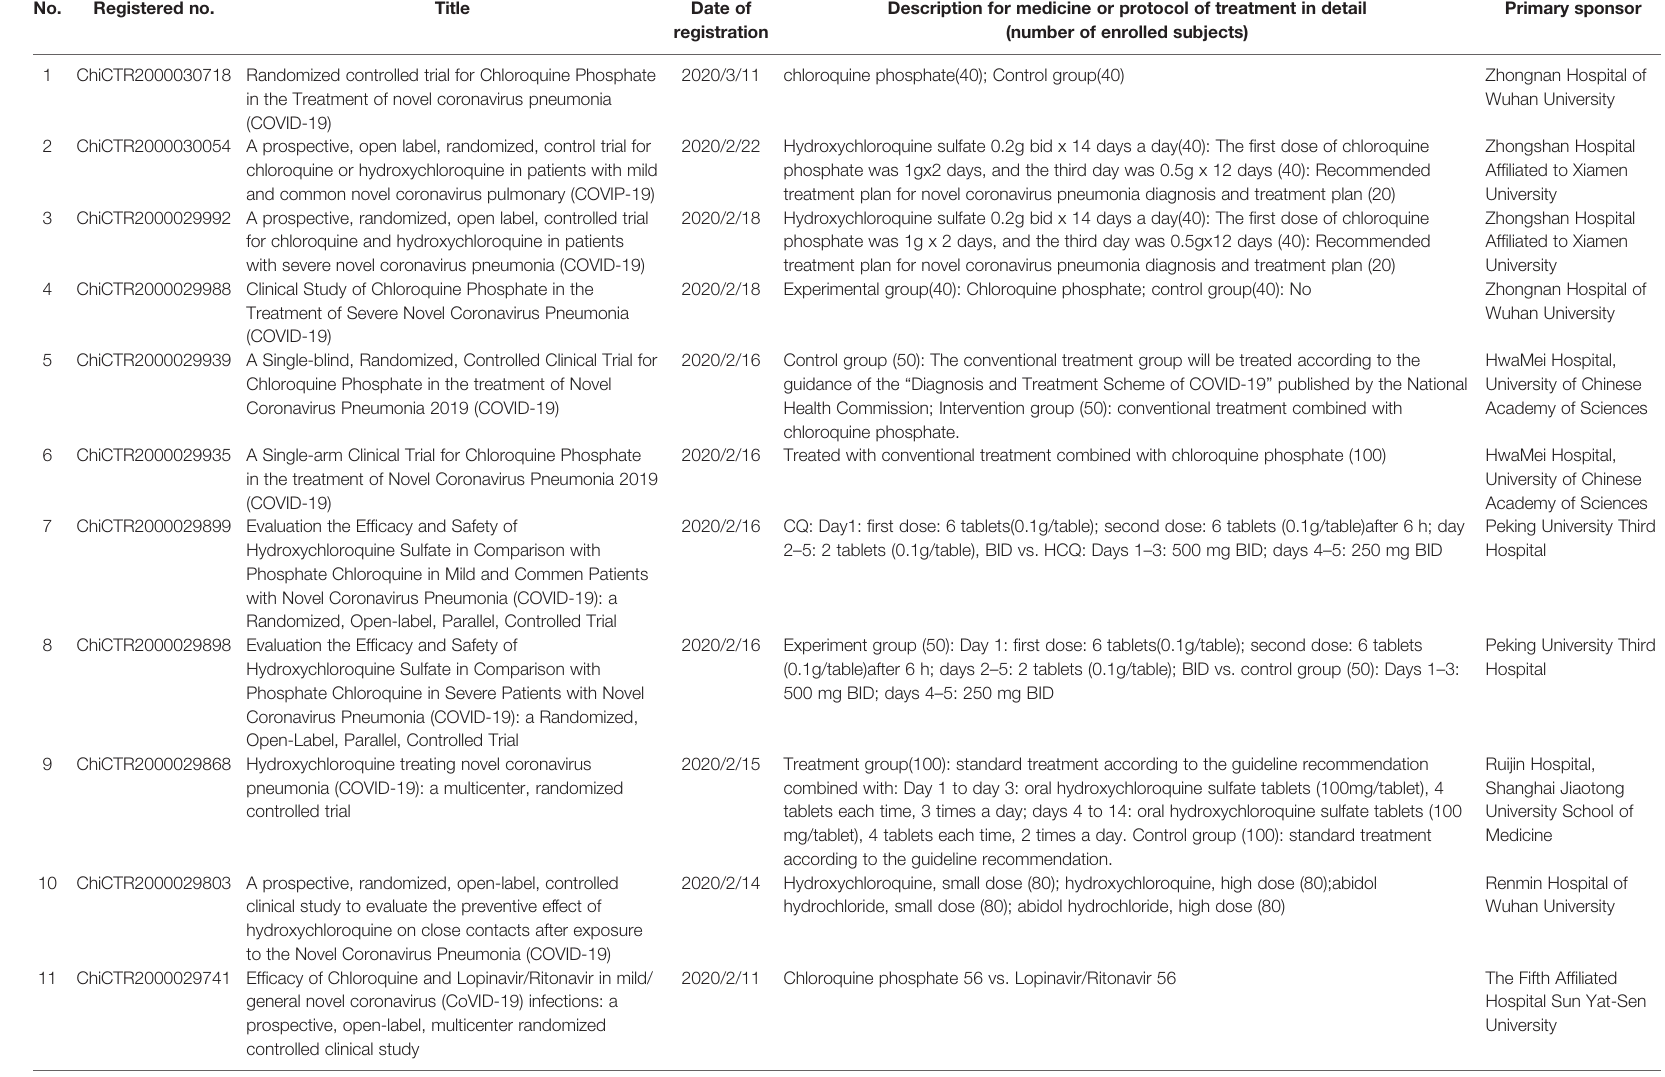
TABLE 1 | Registered clinical trial of CQ and its analogs on treatment of COVID-2019. No. Registered